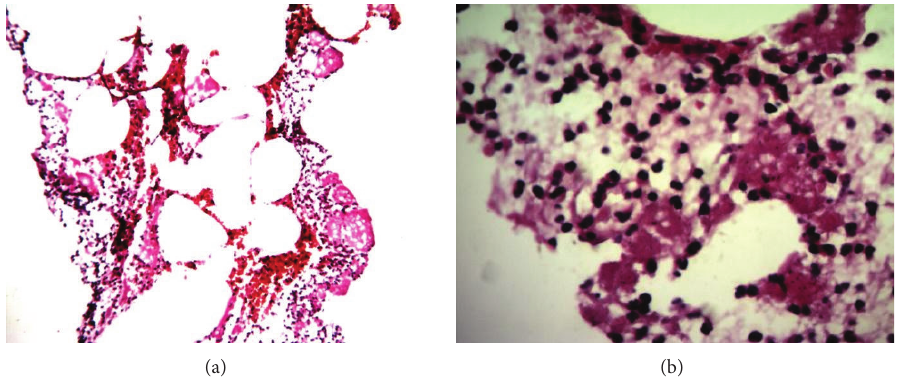
Figure 2: Microscopic examination of right atrial mass in the